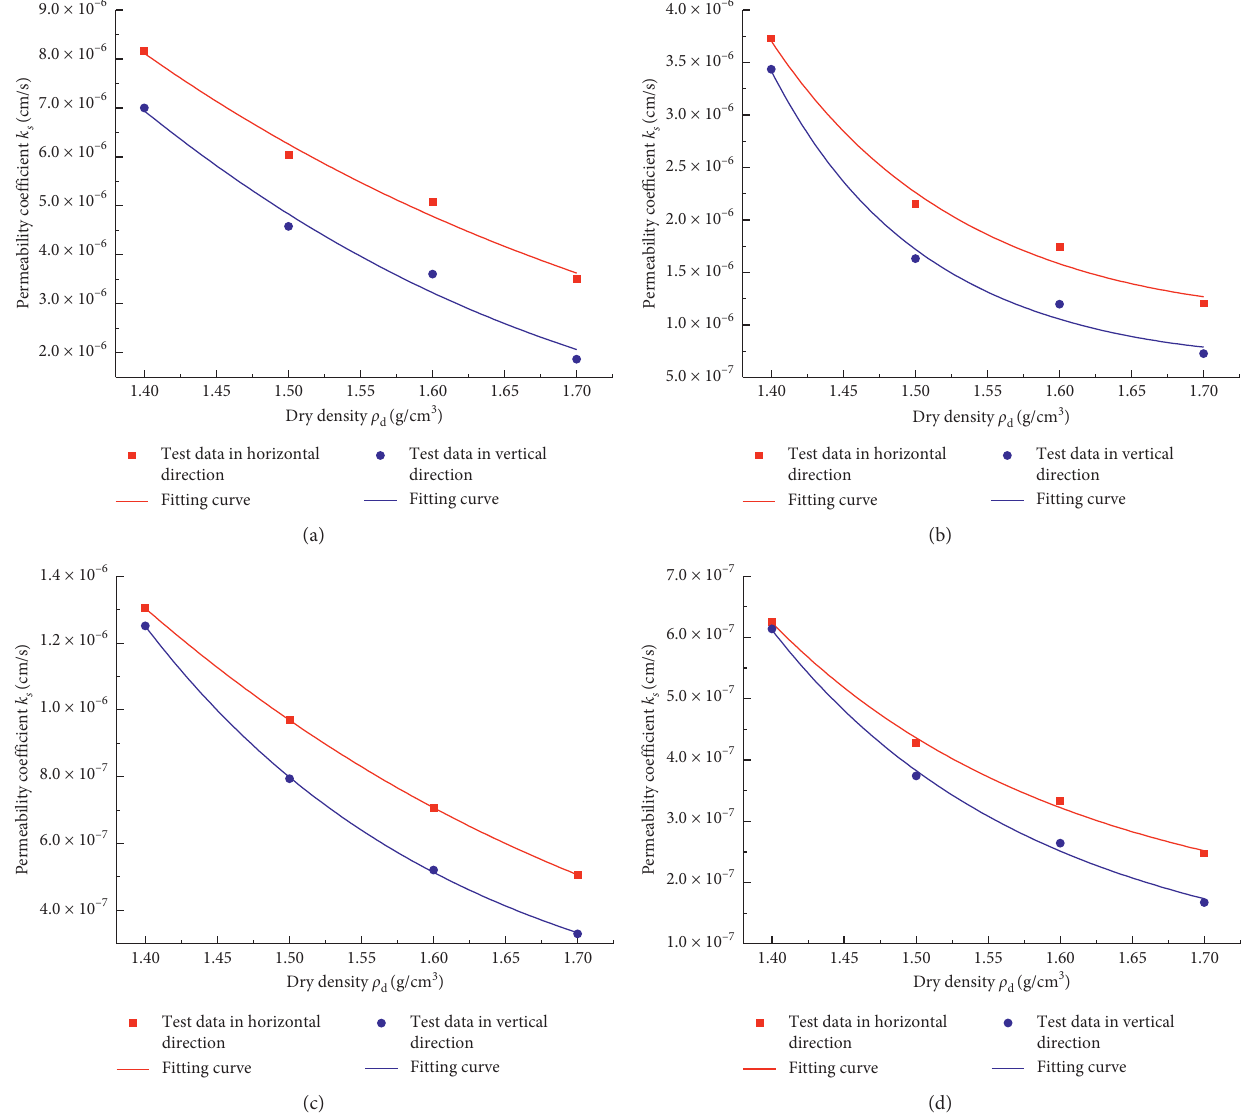
Figure 6: Relationship between the saturated permeability coefficient and the initial dry density under confining pressure consolidation. (a) σ 3 � 100kPa. (b) σ 3 � 200kPa. (c) σ 3 � 300kPa. (d) σ 3 �